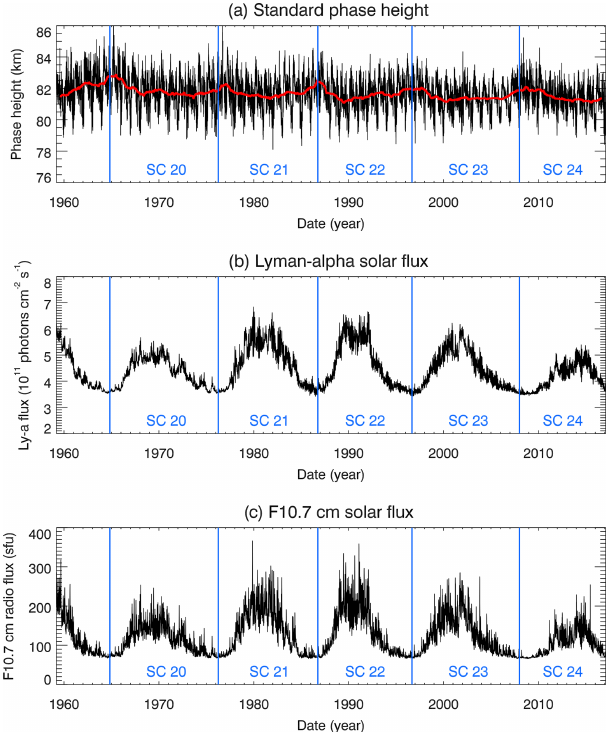
Figure 1. Time series of standard phase height (a) , solar Lyman- α (alpha) flux (b) and F10.7cm solar flux (c) for the period from February 1959 to February 2017 (SC refers to solar cycle). The red line in the top panel corresponds to a 365-day running mean. The repeating pattern with a period of 1 year is the seasonal cycle in standard phase height data further discussed in Peters and Entzian (2015). An 11-year solar cycle signature is also discernible in the standard phase height time